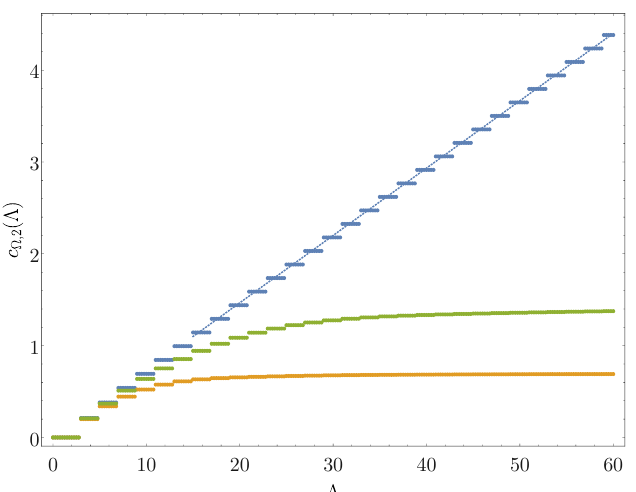
Figure 3. Order λ 2 contribution to the Casimir energy of the φ 2 flow, where the UV theory is √ a massive free boson with ∆ = 2 . The notation c is defined in (3.19). Blue dots: the theory i,n without a spatial cutoff as given by (3.8a); green resp. orange dots: the same theory cut off at (cid:15) = 1 / 10 resp. (cid:15) = 1 / 5 . Notice that the Casimir energy of the full theory diverges linearly with Λ , whereas the same interaction with (cid:15) > 0 asymptotes to a finite value. The asymptotic value appears to be reached when Λ ∼ 1 /(cid:15) . The dotted blue line shows the large- Λ behavior predicted using (3.9).